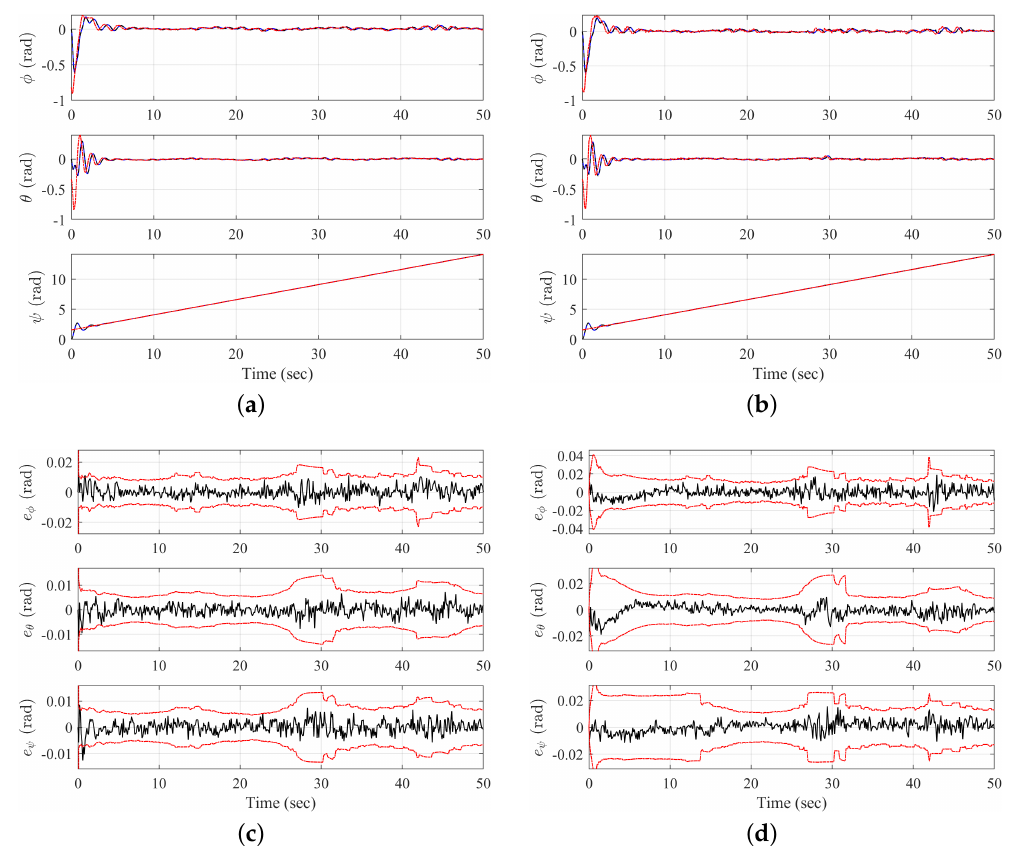
Figure 10. Quadcopter’s estimated Euler angles and corresponding estimation error when fol- lowing an 8-shape trajectory for different cases. For ( a ) attitude for known landmarks and ( b ) attitude for unknown landmarks, true states ( ), estimated states ( ), and desired states ( ). For ( c ) estimated attitude error for known landmarks and ( d ) estimated attitude error for unknown landmarks, estimation error ( ), and 3 σ boundary (